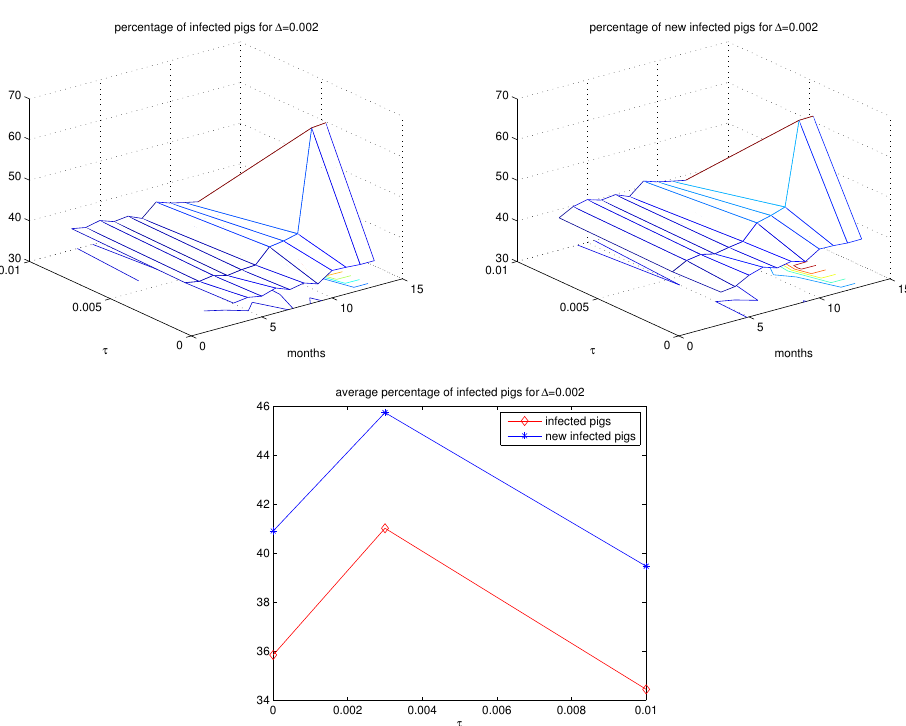
Fig. 15 Top. Left: Percentage of infected pigs evolution in case of bad implementation of the vaccine. Here we fix the value of biohazard rate at ∆ = 0 . 002. Right: The same figure for new infected pigs. Bottom. Averages in time as function of τ of the percentage of infected pigs evolution in case of bad implementation of the vaccine. Here we fix the value of biohazard rate at ∆ = 0 .